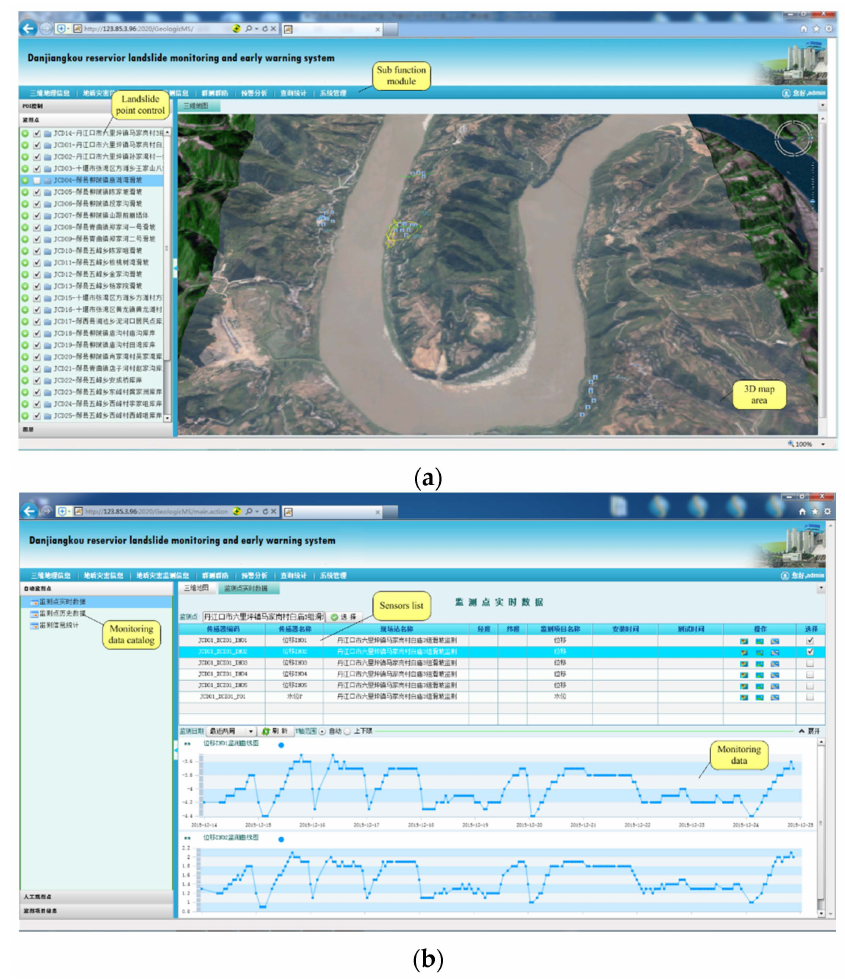
Figure 7. System interface: ( a ) the 3D map page; ( b ) the monitoring data